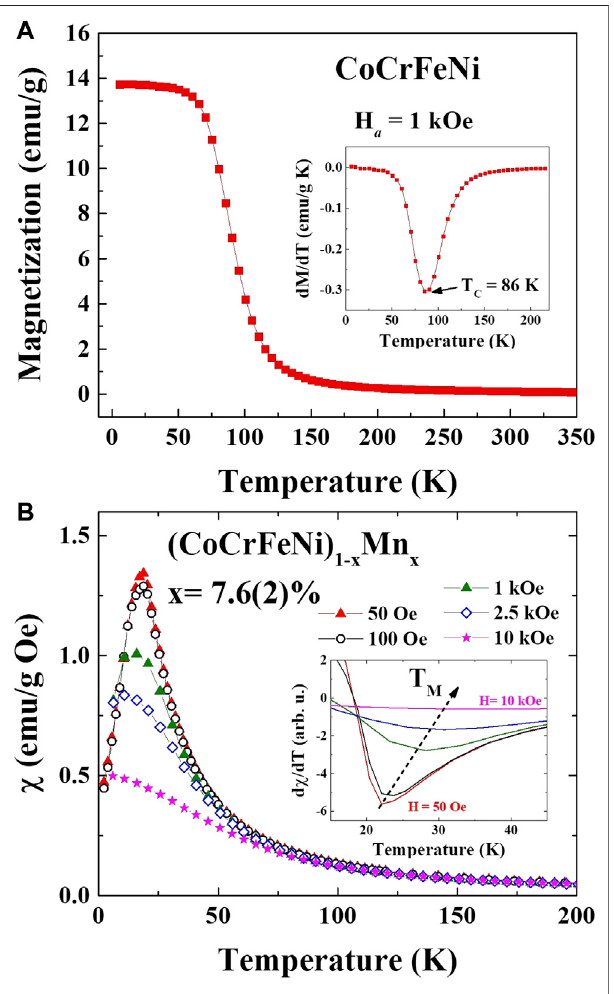
FIGURE 3 | M ( H ) curves of (A) the Mn-free CoCrFeNi HEA and (B) (CoCrFeNi) 1 − x Mn x HEA at x = 7.6%, measured at several representative temperatures. The insets show the magnetic hysteresis at 5